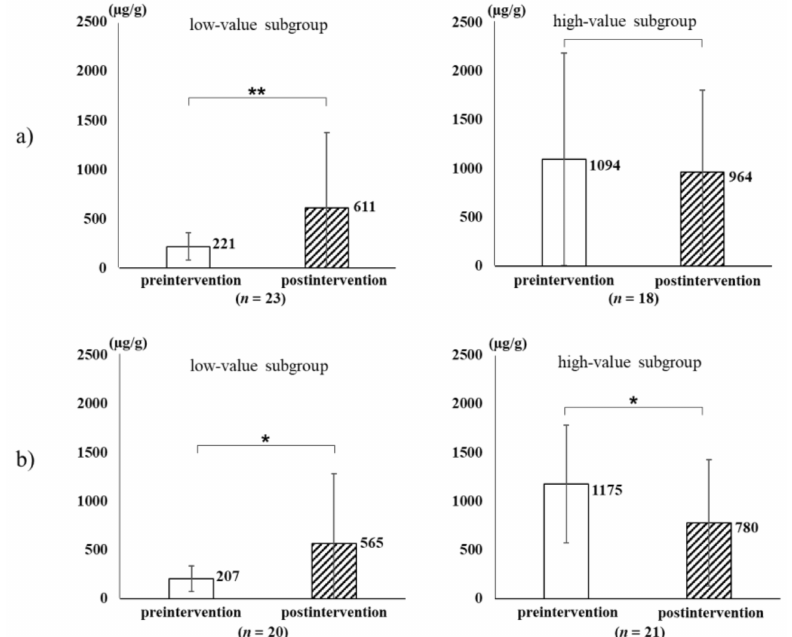
Figure 2. Differences in the changes to sIgA concentrations throughout the intervention period in the MIU ( a ) and control ( b ) groups. Participants in the MIU and control groups was further classified into 2 subgroups: low and high sIgA preintervention levels (<500 vs. ≥ 500 µ g/g). The concentration of sIgA throughout the intervention period significantly increased in both low-value subgroups irrespective of the water type. However, sIgA significantly decreased in the high-value subgroup of the control group but remained unchanged in the MIU group. Open bar, preintervention; hatched bar, postintervention. Bar depicts standard deviation. * p < 0.05; ** p < 0.01.